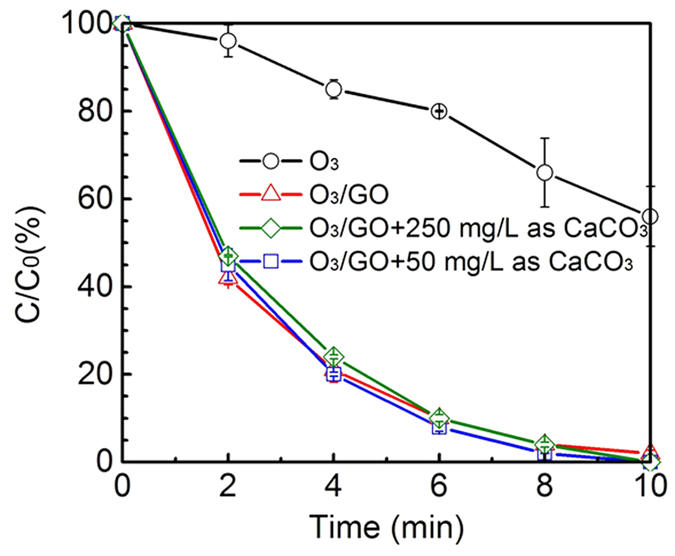
Normalized DEET concentration as a function of time in the presence of HCO3−.Experiment conditions: [DEET] = 50 μM, [GO] = 20 mg/L, [PBS] = 10 mM, pH = 7.